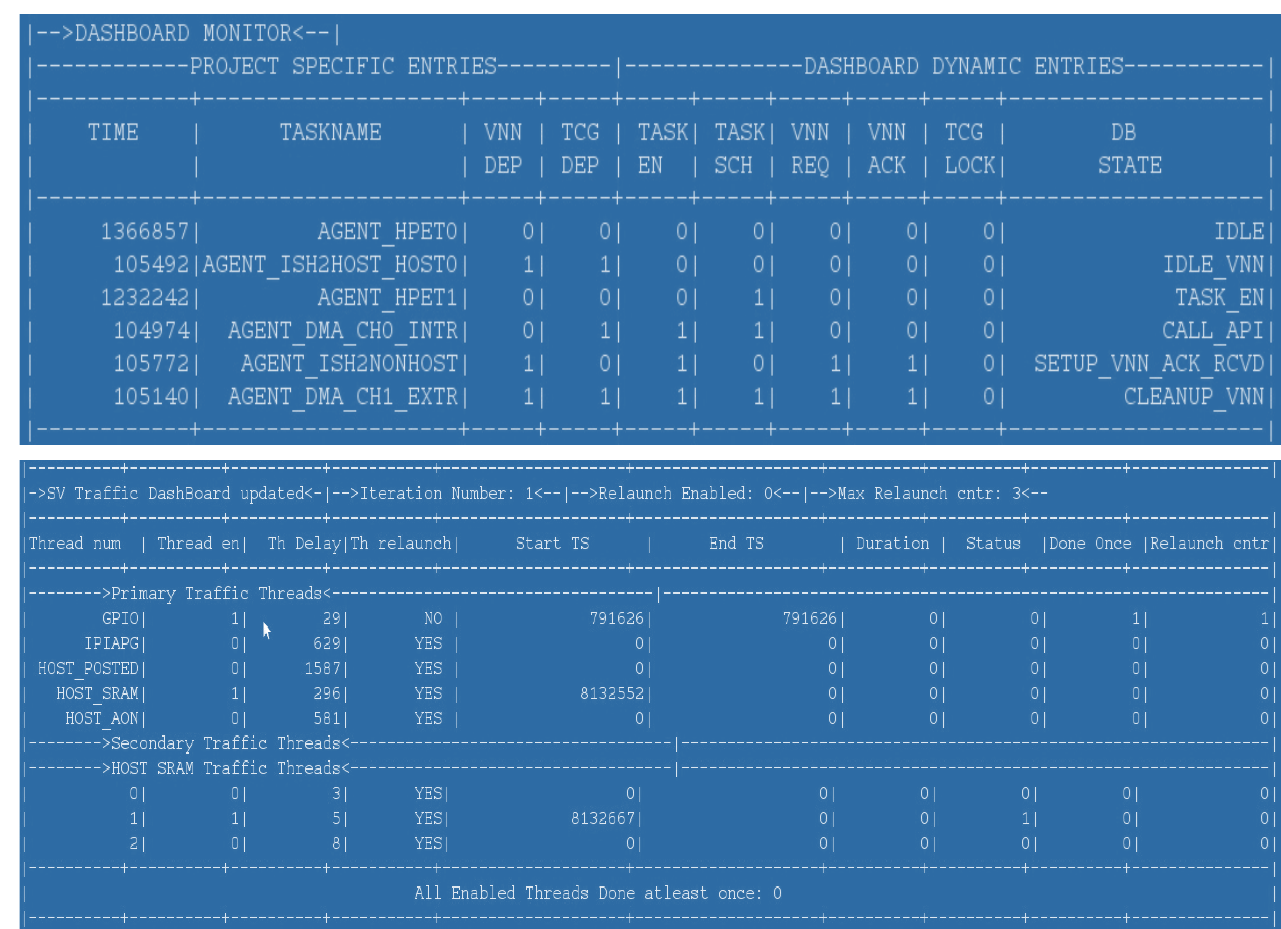
Fig. 5. C and SV engine monitors